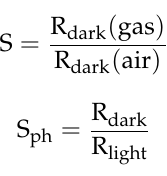
Figure 7. Photoresponse of synthesized samples.